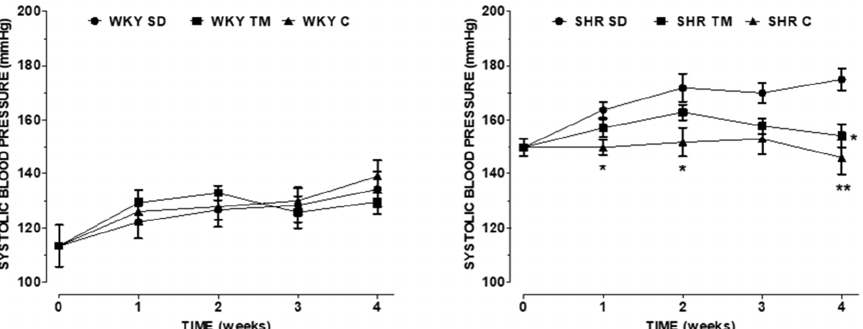
Figure 1. Systolic blood pressure measured during the experimental trial in the six groups under investigation. Left panel: WKY rats; right panel: SHRs. * p < 0.05, ** p < 0.01, vs. SD at the same time (two-way ANOVA followed by Bonferroni post-test). SD: standard diet; C: captopril; TM: Tenebrio molitor .